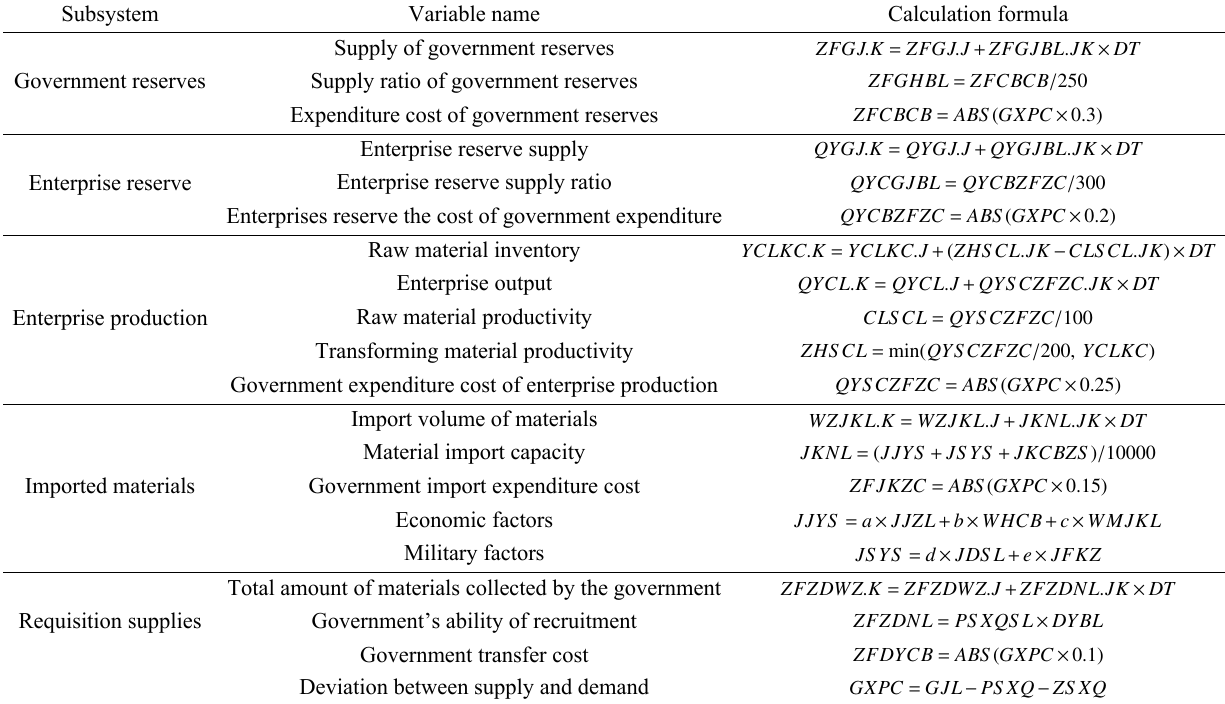
Table 1 Main equations of each subsystem.